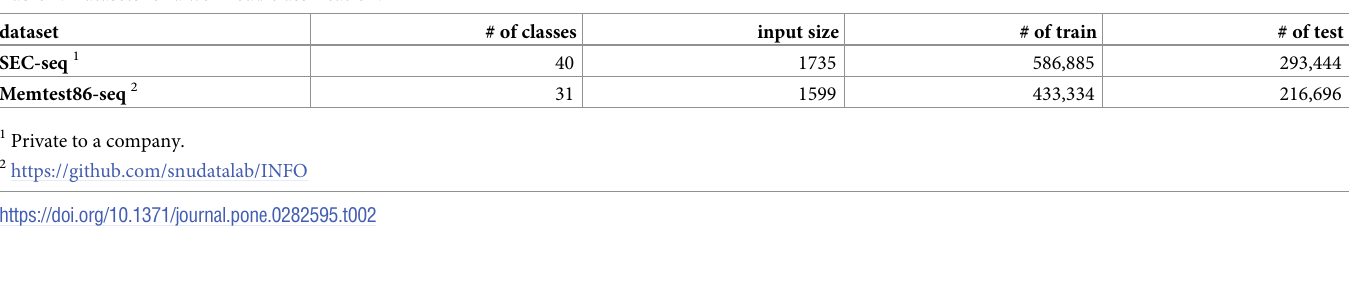
Table 2. Datasets for a workload